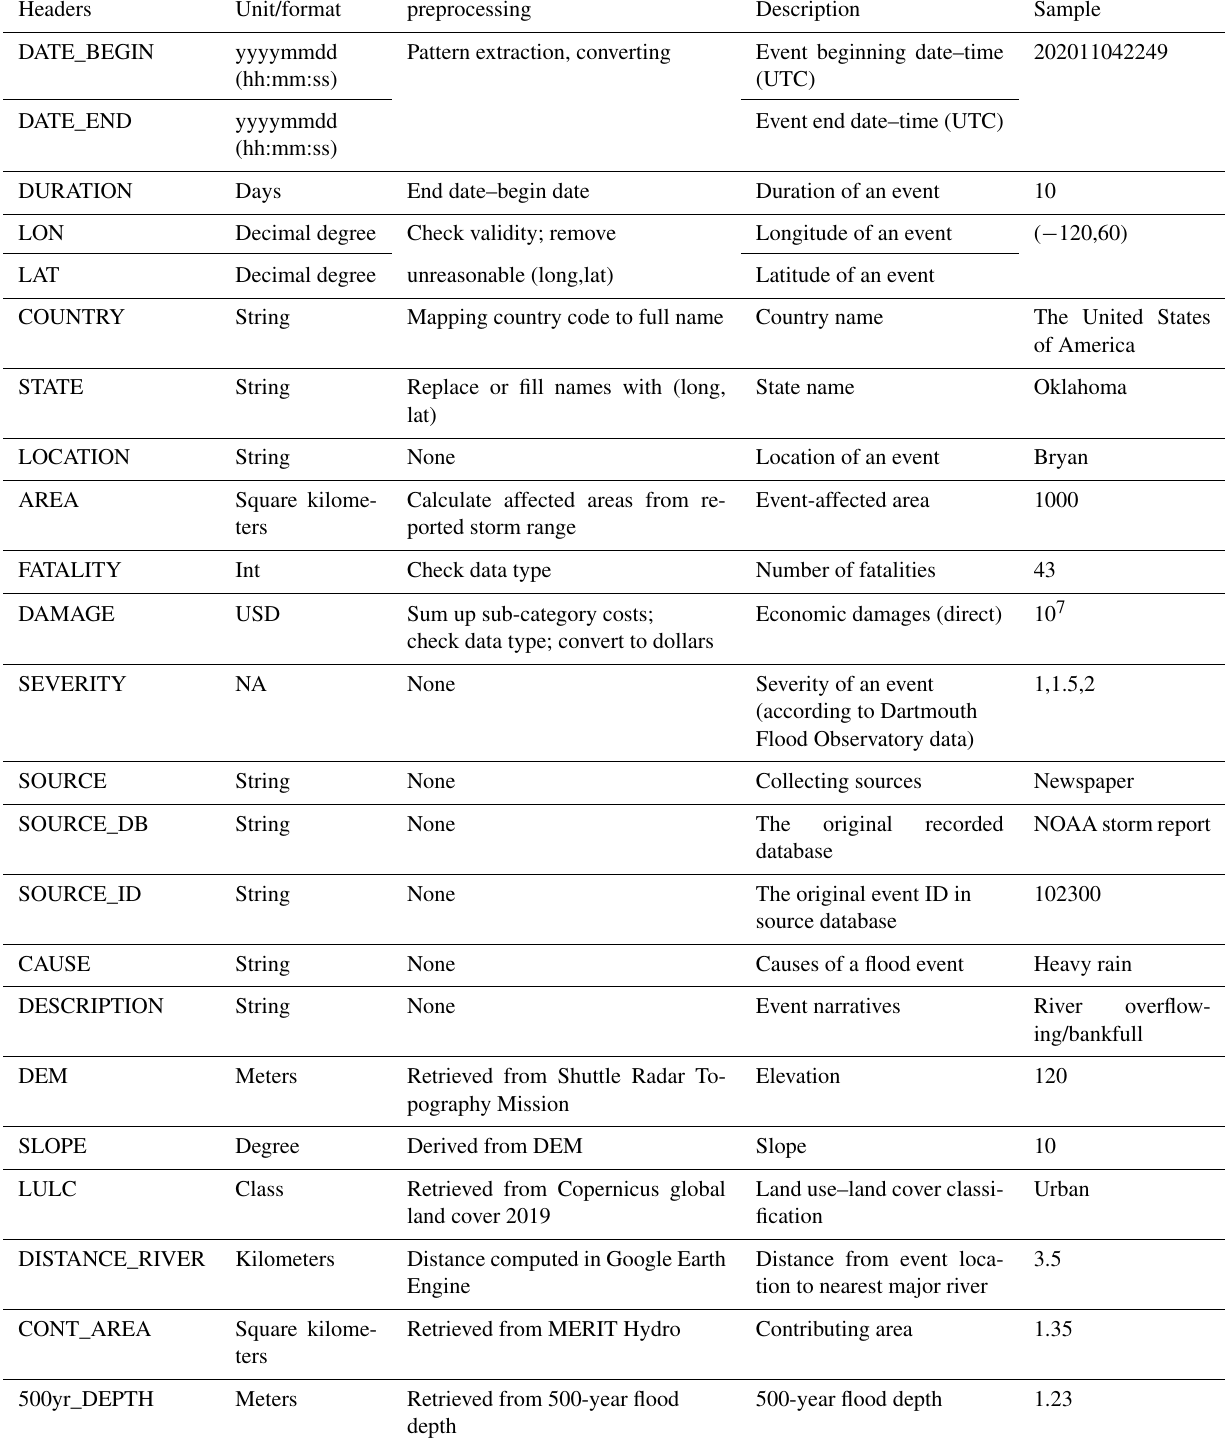
Table 1. Descriptors in the USFD